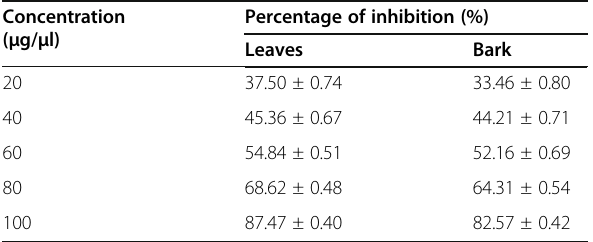
Table 7 Alpha amylase inhibitory assay of S . palghatense leaves and bark Concentration ( μ g/ μ